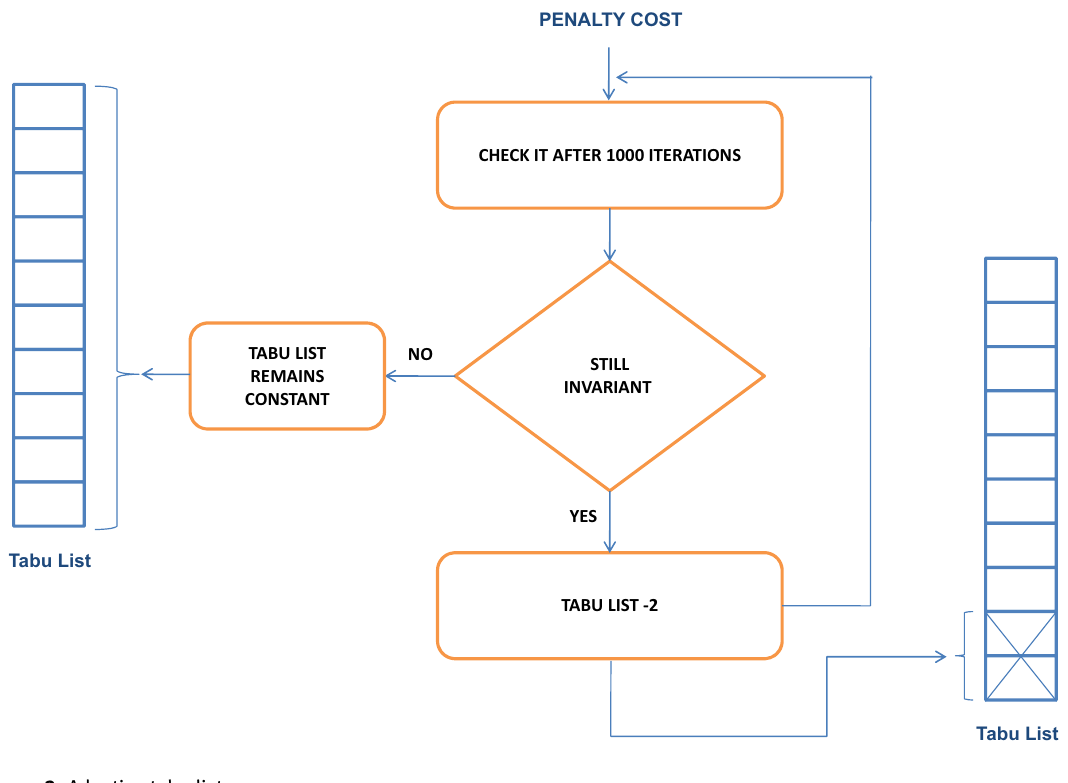
Figure 3: Adaptive tabu list.